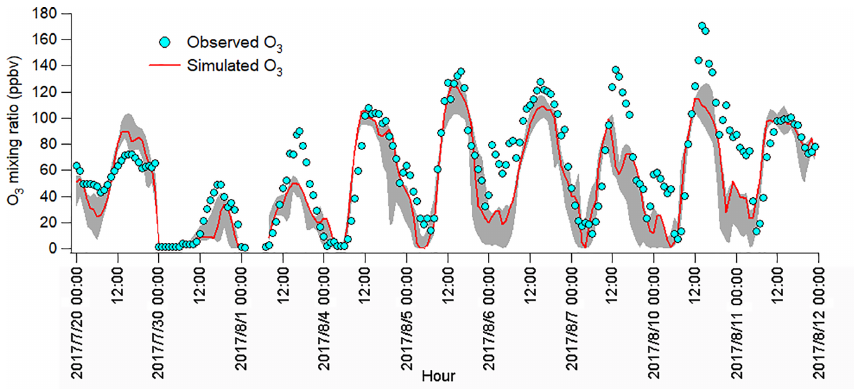
Figure 5. Hourly average mixing ratios of the WRF-CMAQ simulated and observed O 3 in Jinan. The grey area shows the minimum and maximum simulated O 3 at the sampling site and eight adjoining grids (12km × 12km for each grid).